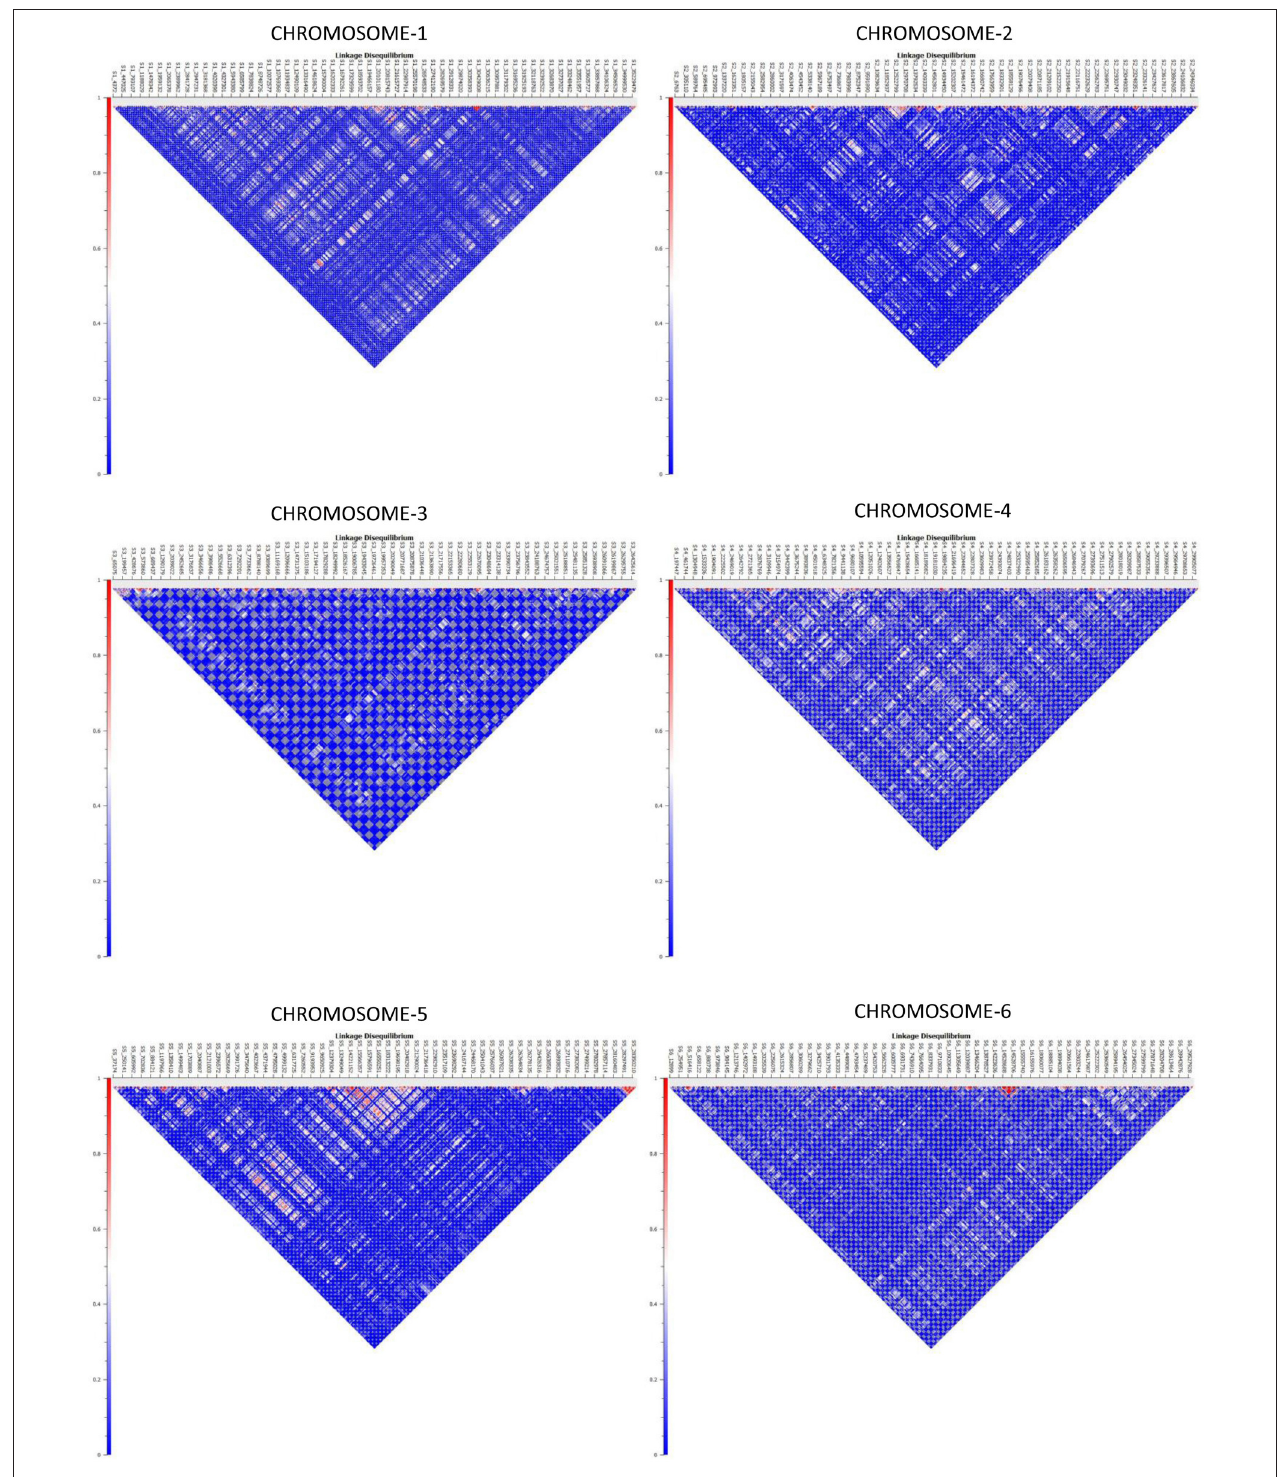
FIGURE 3 | Genome-wide distribution of LD ( r 2 ) across melon chromosomes 1–6. X-axis contains the SNP markers positioned on the physical map. Y-axis represents the intensity of LD as shown in the scale.